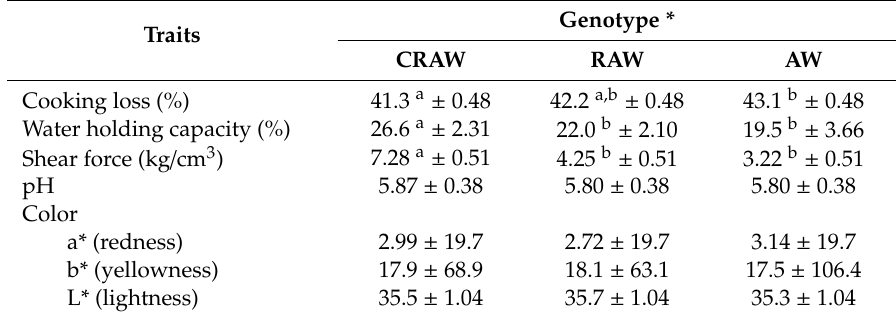
Table 4. Means ( ± SEM) meat quality characteristics of the first backcross callipyge Awassi-Rambouillet (CRAW), Rambouillet–Awassi (RAW), and Awassi (AW) lambs.